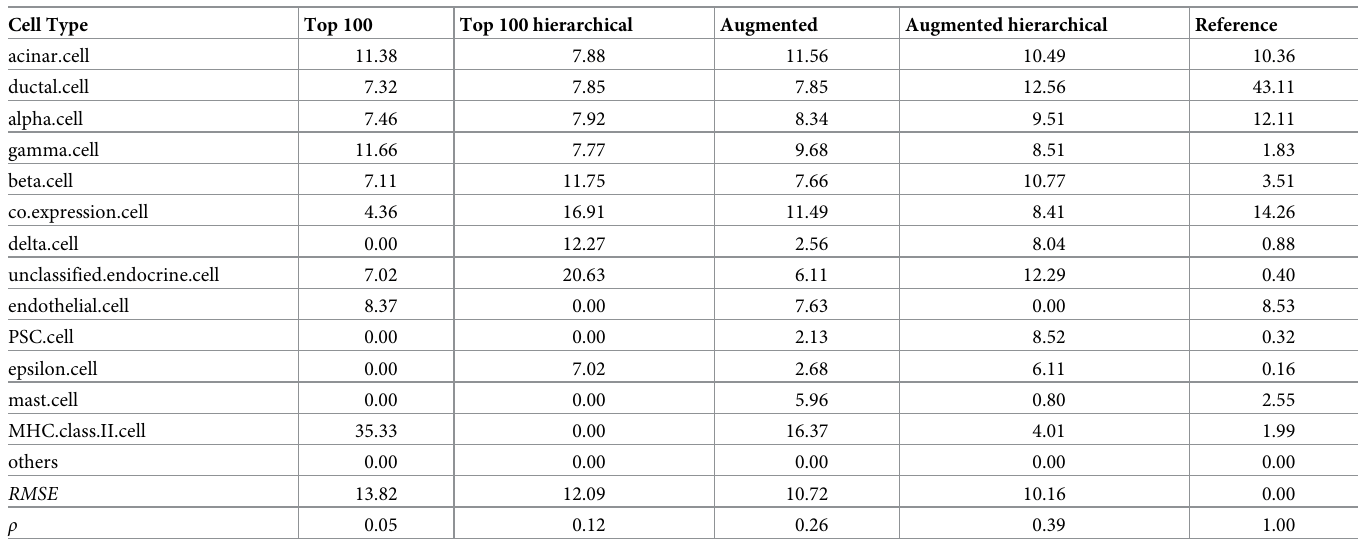
Table 4. Deconvolution of pancreas training set.